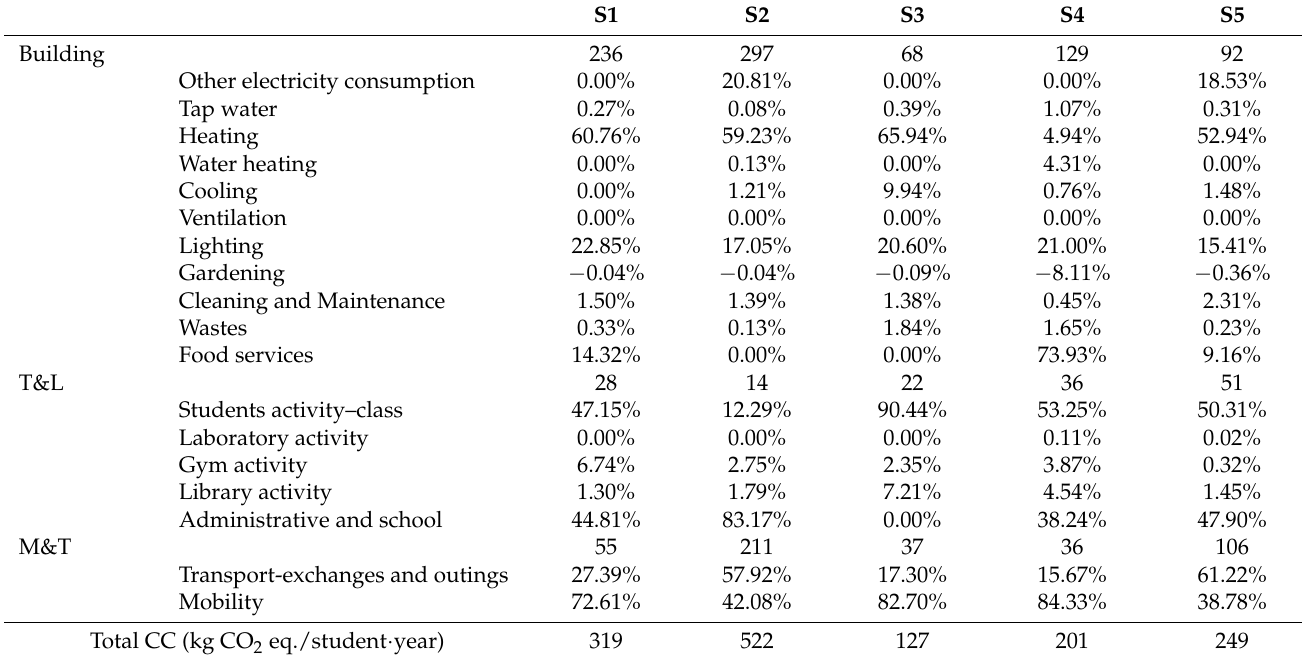
Table 6. Climate change impacts results per school, subsystem, and